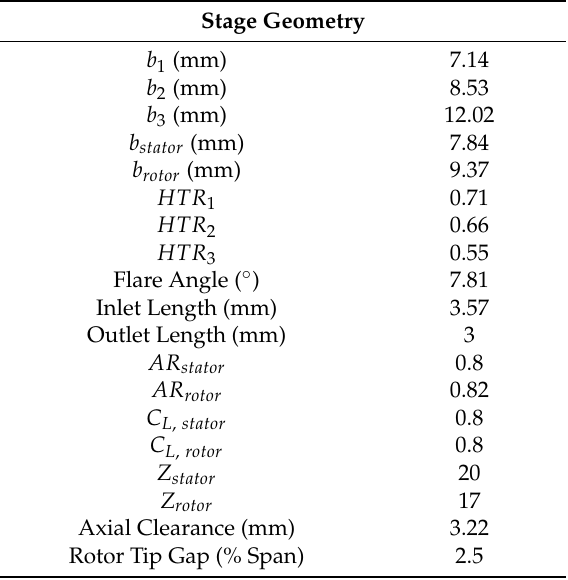
Table 5. Turbine stage geometry for bgi